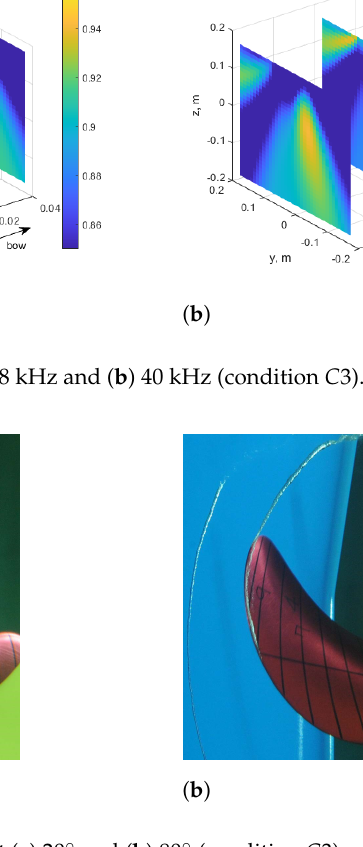
Figure 12. Cavitation pattern at ( a ) 20 ◦ and ( b ) 80 ◦ (condition C 3). From the α map, the maximum value was found, and the corresponding source level was obtained. Having obtained the source level at all frequencies, the result was compared with the measured source level, which is shown in Figure 13 in terms of spectral density. Overall, the calculated source level agreed well with the measured one from 2 to 50 kHz. The differences below 2 kHz were due to the combination of the monopole assumption and the transducer characteristics. Above 50 kHz, the transfer function could not be applied, and thus, the predicted source level deviated from the measured one. From this, it can be said that the proposed method is valid.